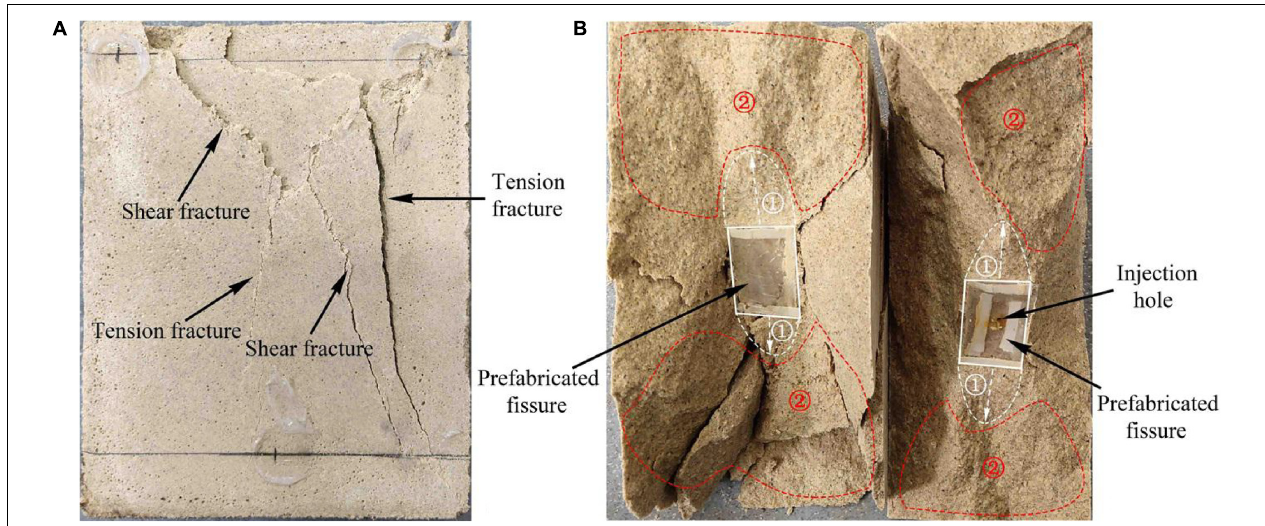
FIGURE 9 | Images showing the uniaxial compression failure mode of a specimen with an internal fracture at an angle of 45 ◦ under a stable hydraulic pressure of 1 MPa: (A) external view and (B) internal fracture plane ( (cid:172) wing crack; (cid:173) shear zone).